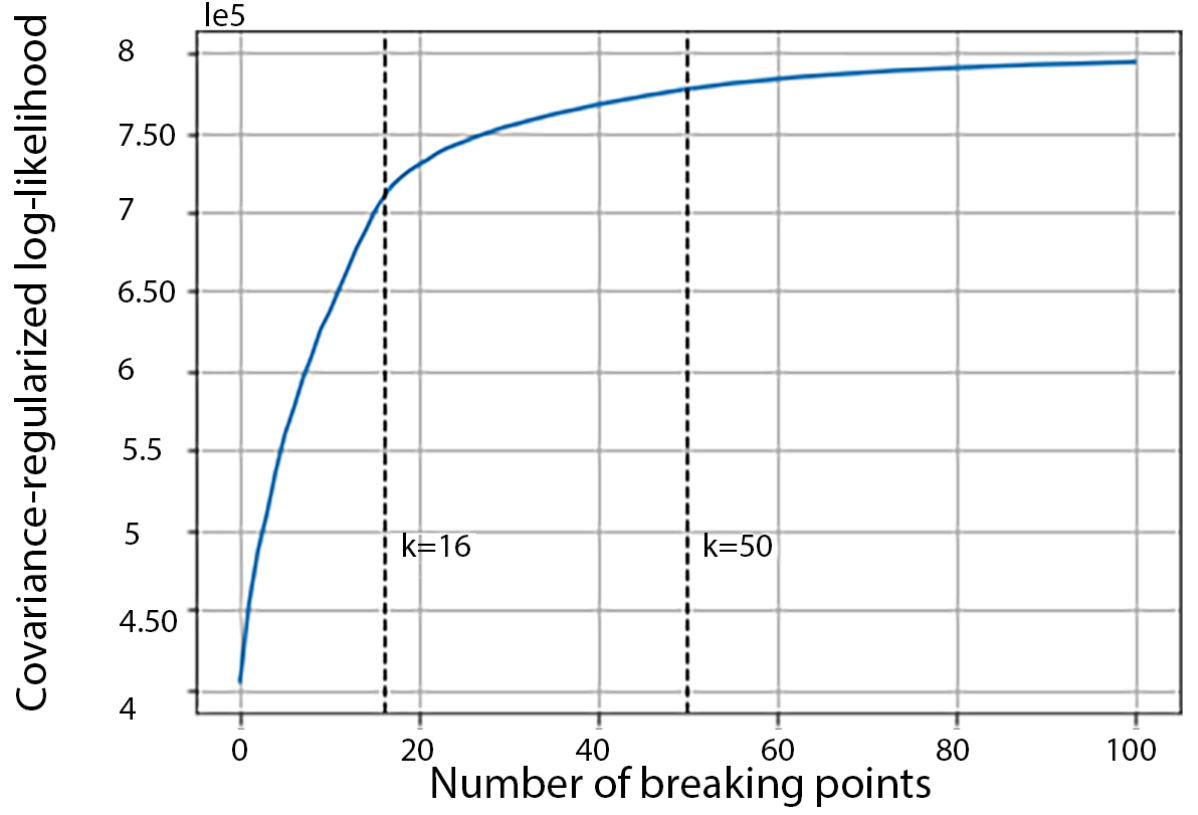
Figure 4. Total covariance-regularized log-likelihood curve of the human activity recognition using smartphones training